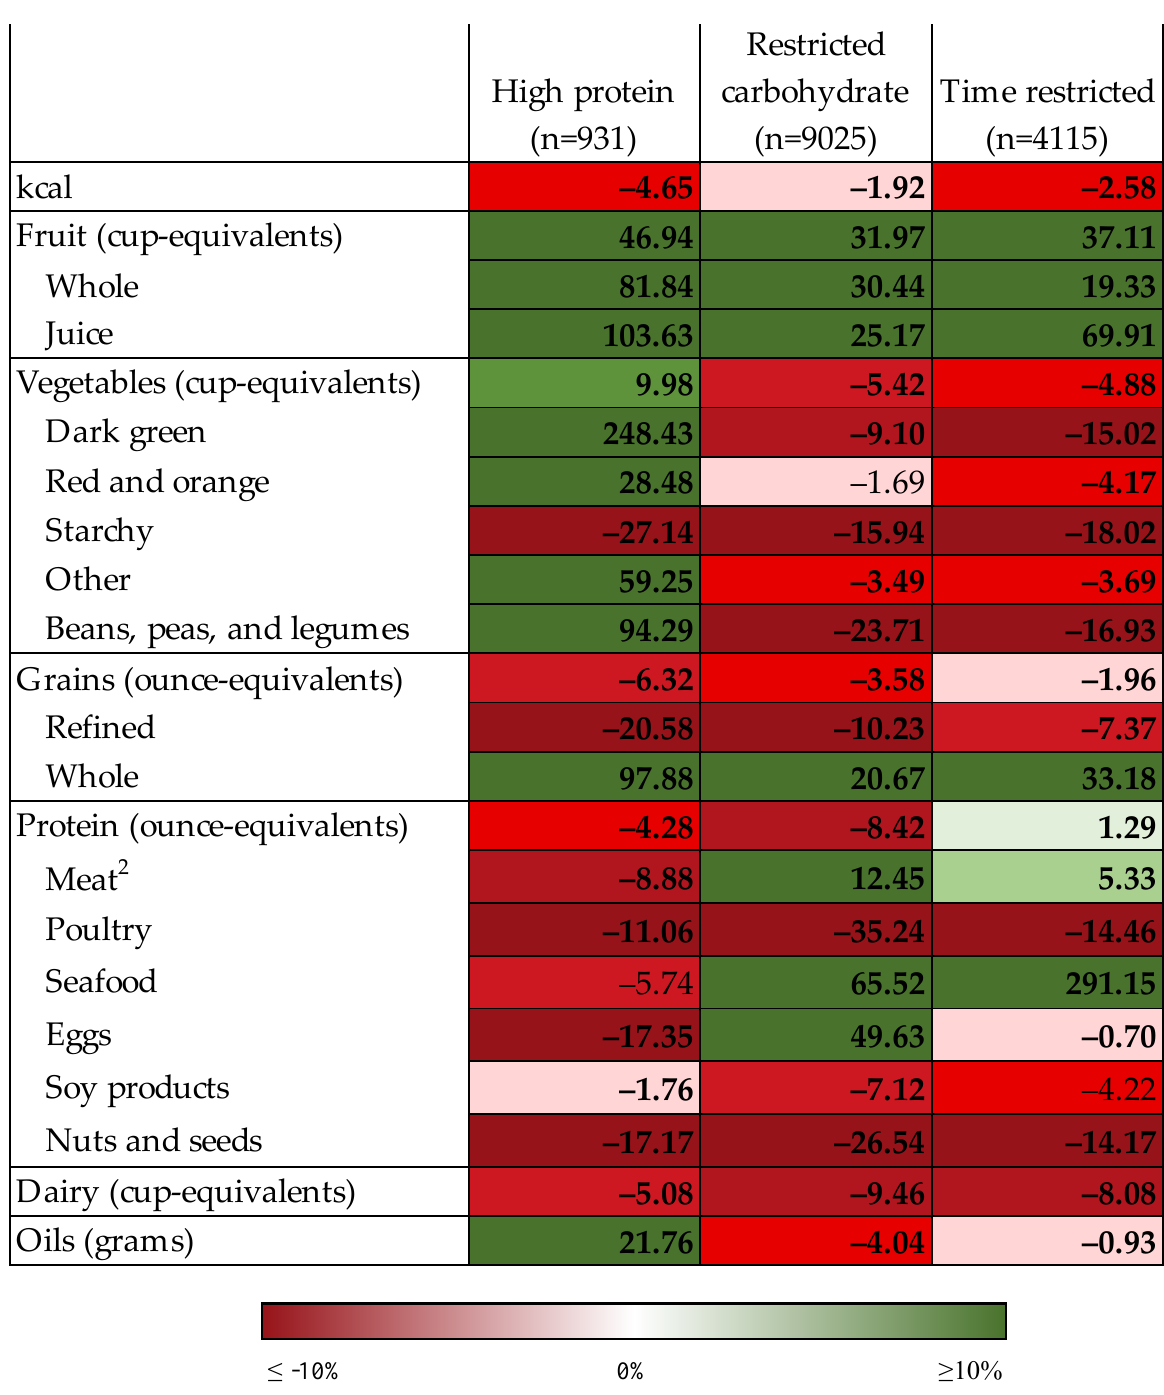
Figure 2. Percent change in intake of food groups under conditions of modeled food replacements 1 for macronutrient-restricted diet patterns and time-restricted diet pattern. Bolded text indicates statistically significant difference between current and modeled intake at p < 0.05 using paired Wald tests. 1 One serving substitution of foods highest in added sugar, sodium, and saturated fat with alternative foods (four servings total). 2 Does not include cured meat and organ meat.